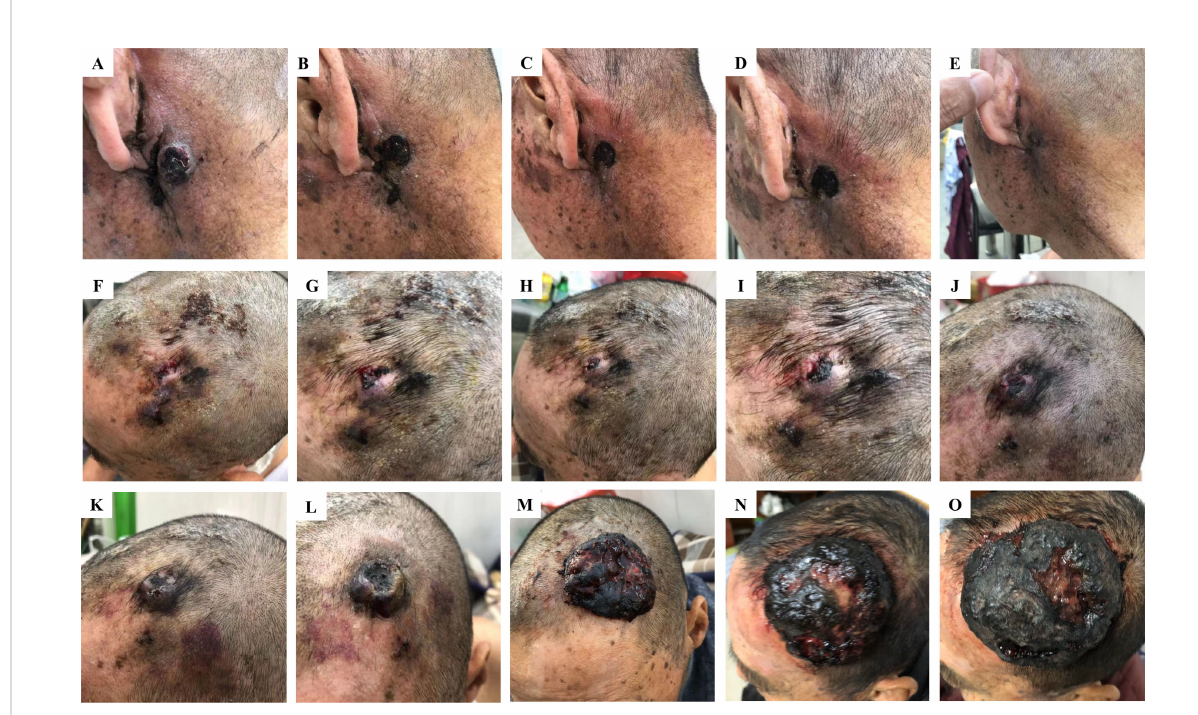
FIGURE 2 Different responses of retro auricular and scalp angiosarcoma metastases to anlotinib treatment. Changes in retro auricular recurrence and overhead metastases during anlotinib treatment on 13 July, 22 July, 25 July, 28 July, and 1 August 2019, respectively. Among them, the retro auricular tumor was relieved quickly after anlotinib treatment, and the bump was gradually reduced to disappear, achieving recovery (A – E) . However, the scalp metastasis of the same period was not effective, and the lesion gradually deteriorated until it was uncontrollable (F – O) . Continuous deterioration of the scalp metastatic during anlotinib maintenance on 4 August (K) , 12 August (L) , 8 October (M) , 19 November (N) , and 10 December 2019 (O)